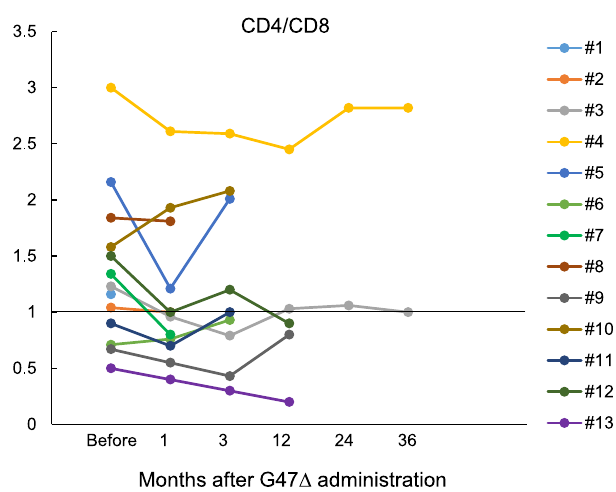
Fig. 6 Blood CD4/CD8 ratio. Blood CD4/CD8 ratio was measured before G47 Δ and 1, 3, 12, 24, and 36 months after the last G47 Δ administration. Patient #4, a long-term survivor, maintained a high CD4/CD8 ratio. Source data are provided as a Source Data fi